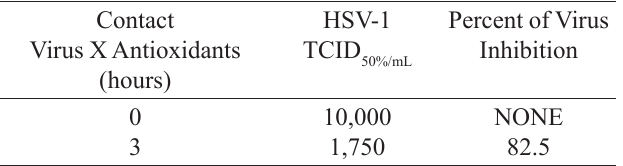
TABLE IV – Inhibitory action of natural antioxidant from rosemary ( Rosmarinus officinalis, L .) 300 ppm and synthetic antioxidant of butyl hydroxyl toluene (BHT) 100 ppm on